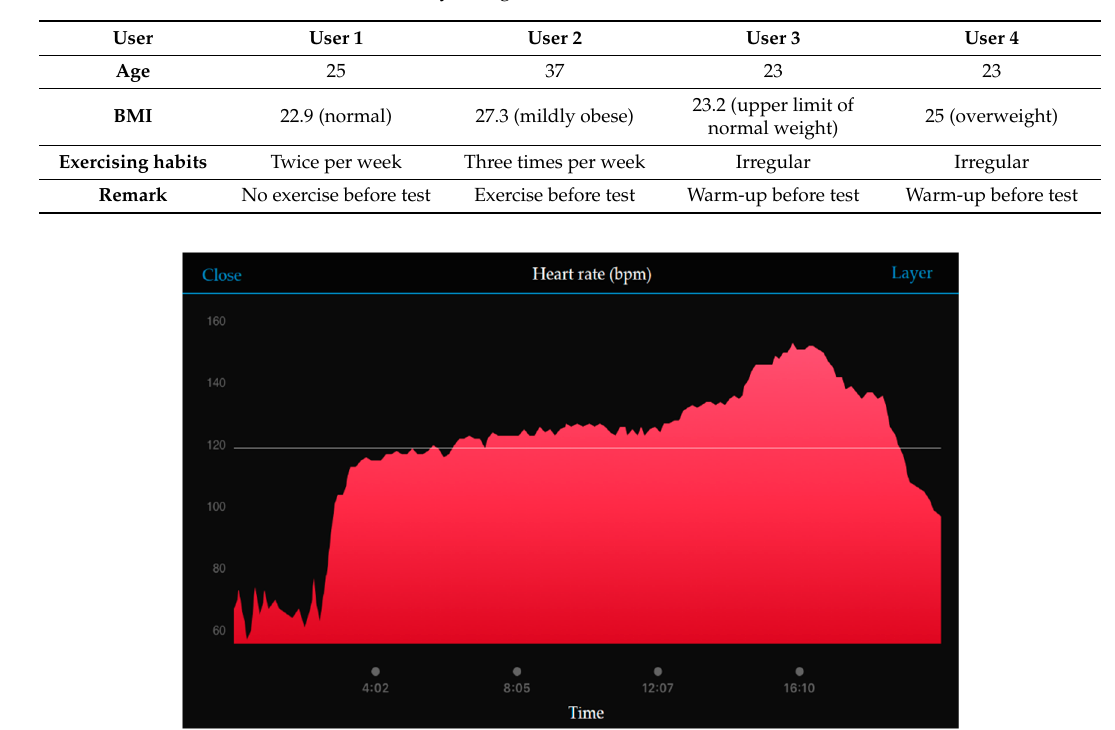
Table 4. Physiological differences between users.